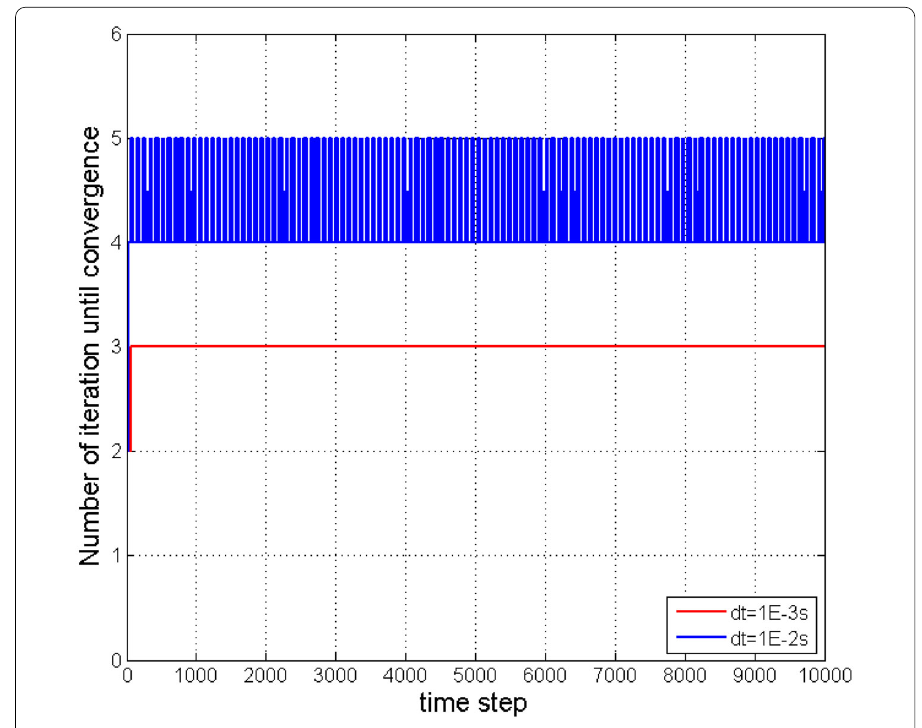
Fig. 6 Number of iterations until